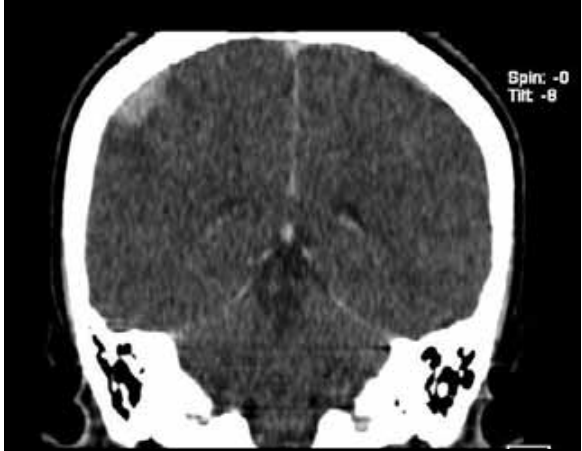
Figure 1 – Preoperative CT scan showing an expansive mass in the right parietal convexity CT: computed tomography.